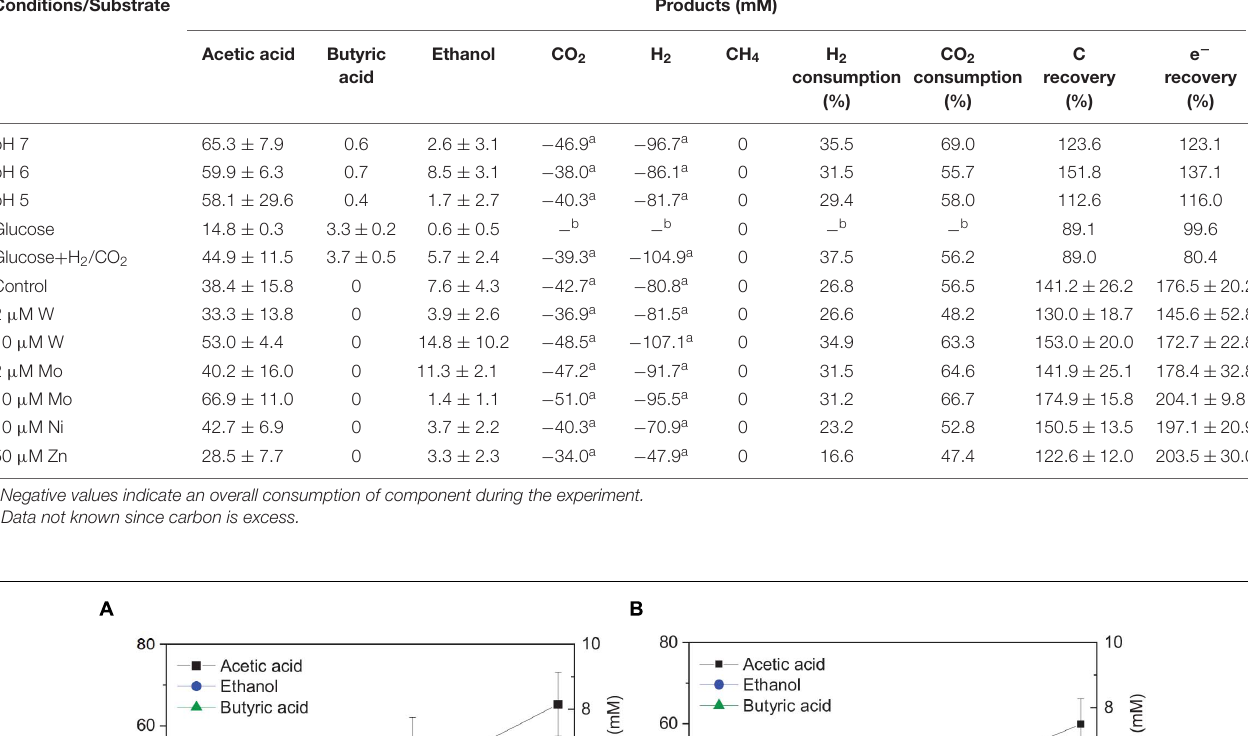
Frontiers in Microbiology |